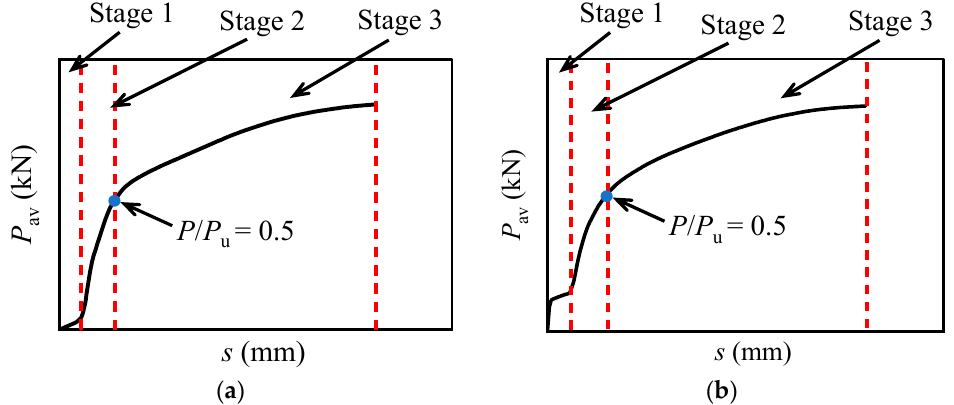
Figure 20. Schematic diagram of the mechanical behavior: ( a ) without preload and interface friction; ( b ) with preload and interface friction.